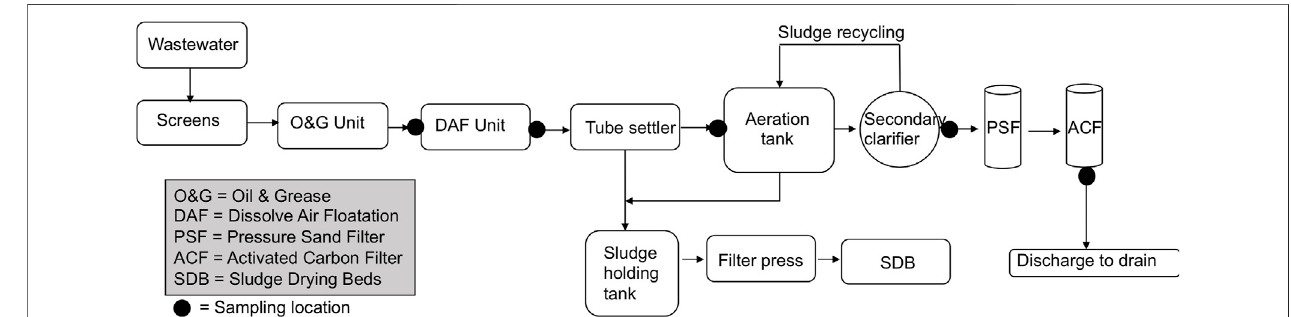
FIGURE 1 | Process fl ow diagram of ETP of Meem